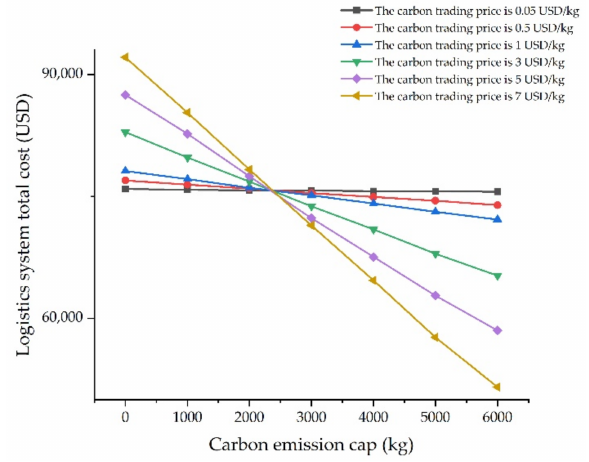
Figure 13. The relationship between total logistics cost and carbon trading price and carbon emission caps in the logistics system.